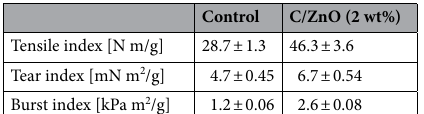
Table 3. The effect of the nanofiller on the mechanical properties of cellulose fibers.